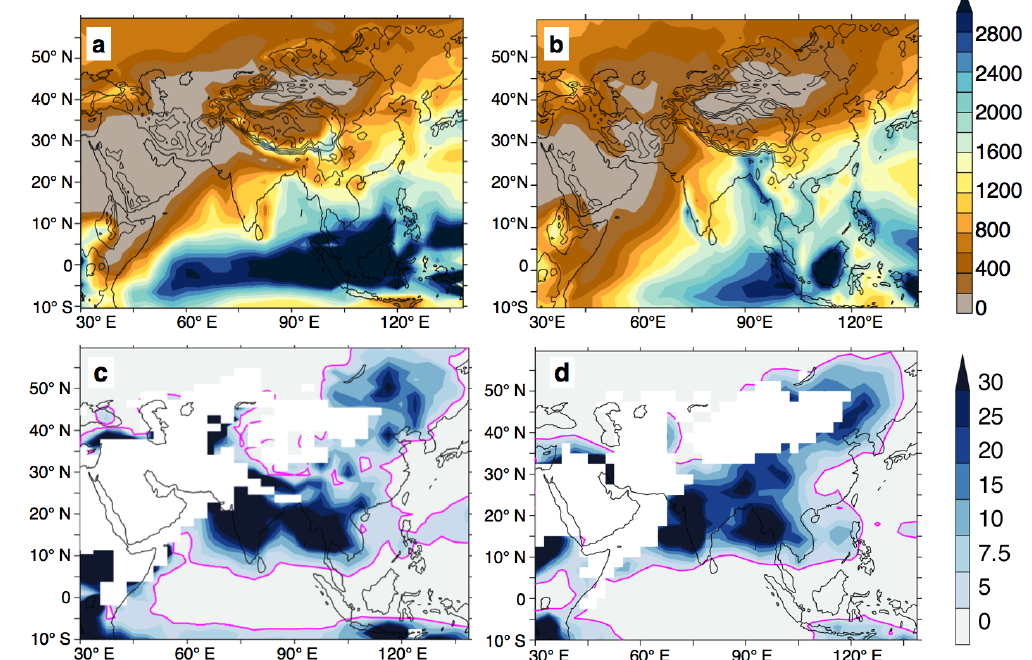
Figure 1. Comparison of (a, b) mean annual precipitations in millimetres per year and (c, d) the 3 wet / 3 dry ratio simulated in (a, c) the modern control simulation and (b, d) the GPCP